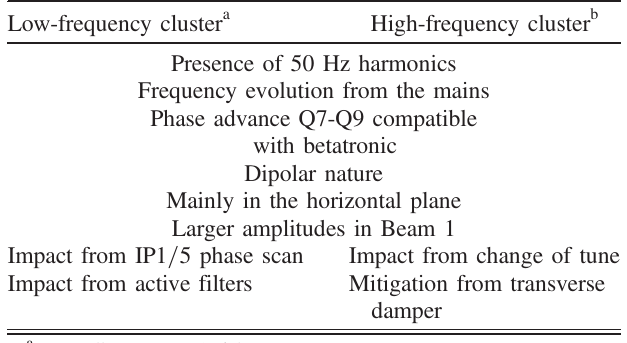
TABLE III. The summary of the observations for the low and high-frequency